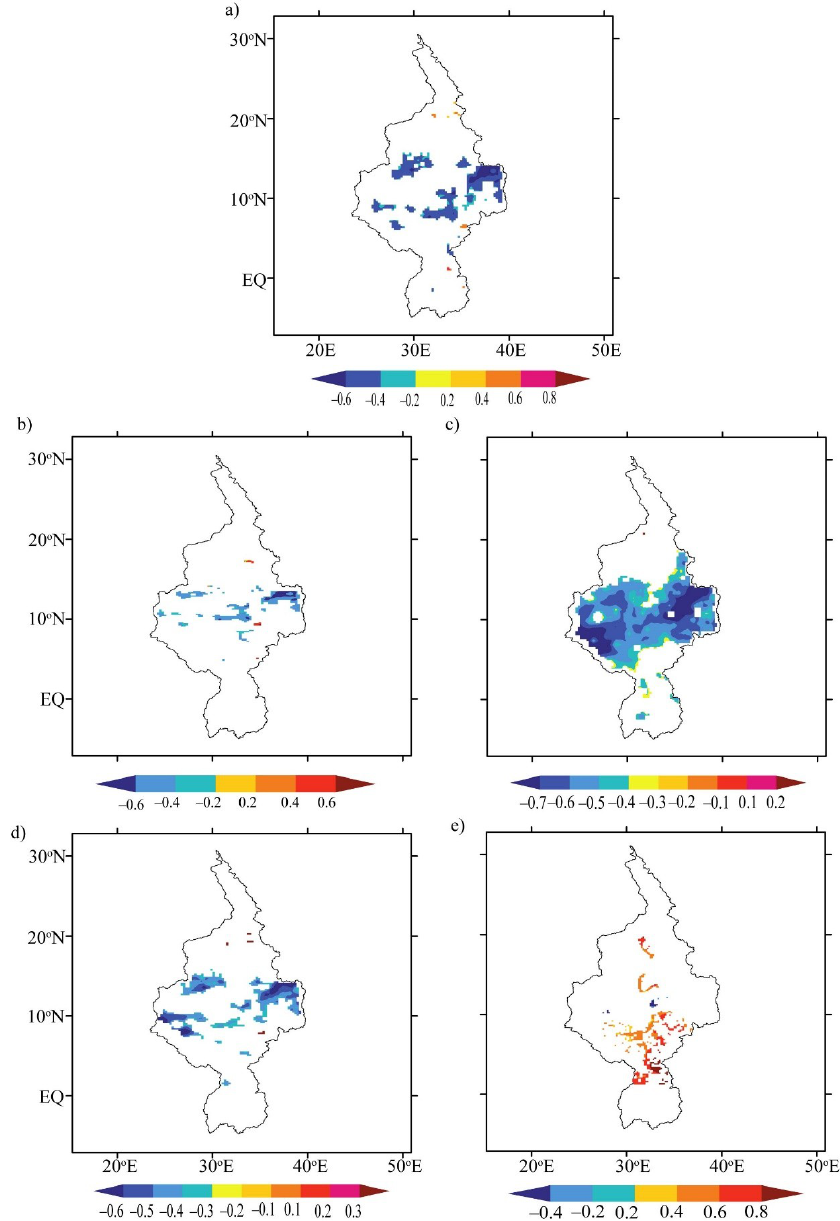
Figure 15. Pixel-wise correlation coefficients between total ET and its components and R n observed in the Nile Basin for 1980–2014: ( a ) total ET, ( b ) transpiration, ( c ) canopy interception, ( d ) bare-soil evaporation, and ( e ) open-water evaporation. The shaded areas denote areas where the tests were significant at the 5% level.